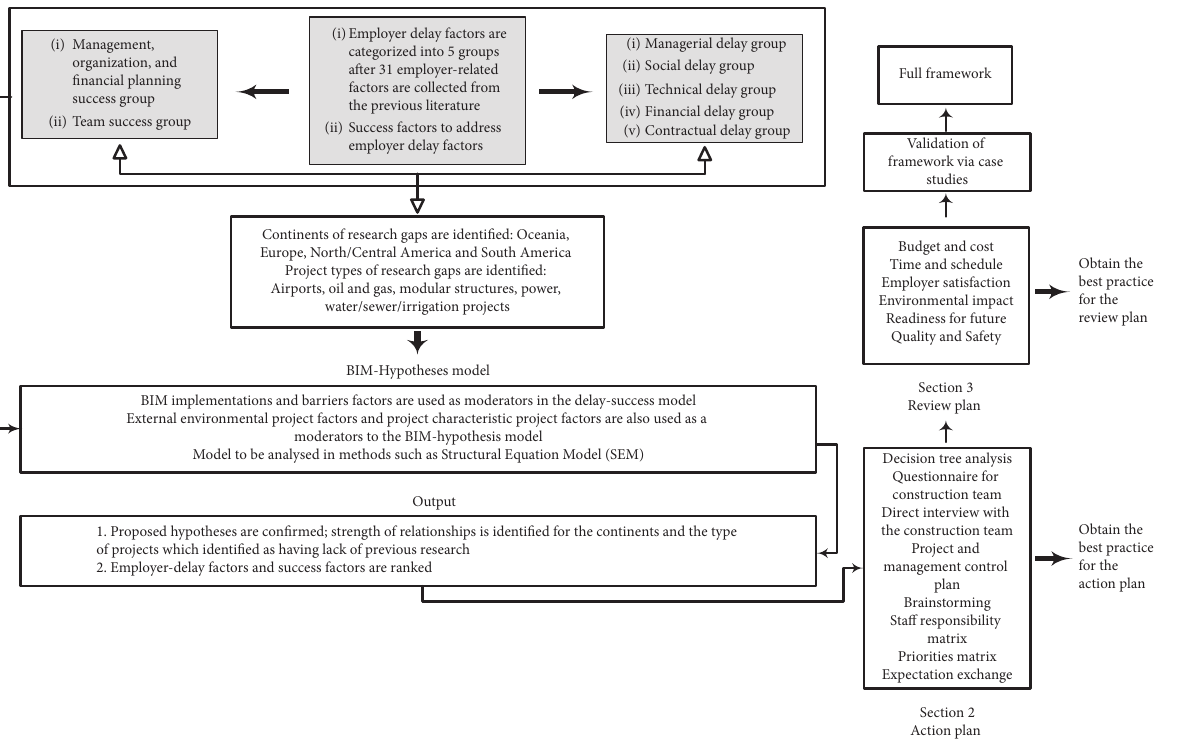
Figure 5: Research framework.